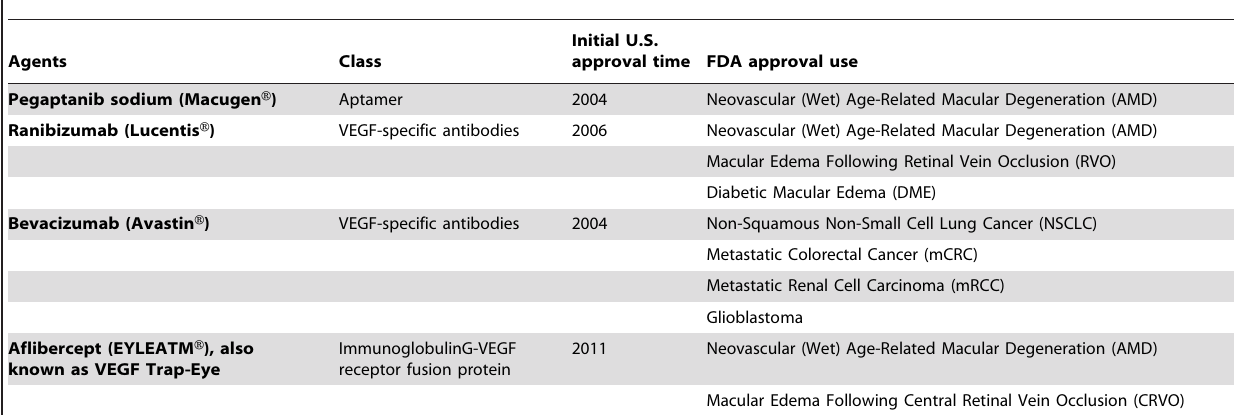
Table 1. Anti-vascular endothelial growth factor included in this meta-analysis.